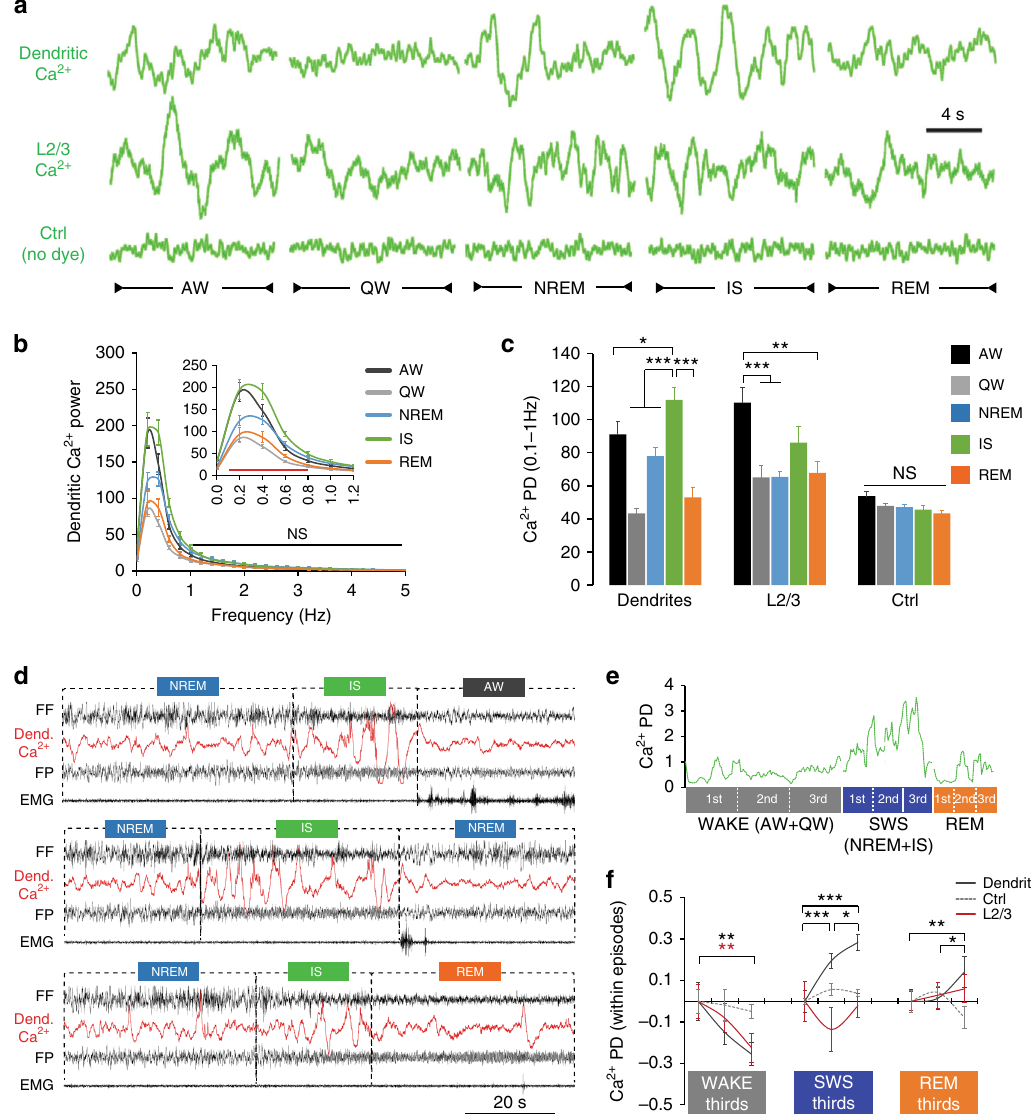
Fig. 2 Ca 2+ activity in populations of dendrites is largest at NREM transitions (IS). a Representative examples of fi bre-optic signals recorded in the three groups for each behavioural state. b Mean ( ± s.e.m.) power spectra of the dendritic Ca 2+ signal in each state (normalised to the mean across behavioural states). Signi fi cant differences between states were only found for frequencies < 1 Hz (two-way ANOVA; factor “ state ” : F 4,1248 = 50.6, P < 0.001; red line ( inset graph ): P < 0.05, black line ( main graph ): P > 0.05, Holm – Sidak test). c Mean ( ± s.e.m.) power density (PD) in the 0.1 – 1 Hz frequency band of the fi bre-optic signal in the three groups across behavioural states (factor “ state ” : F = 26.1, P < 0.001 three-way ANOVA; F = 7.51, 4,44(dendrites) 4,44(L2/3) P < 0.001 two-way ANOVA; F 4,20(Ctrl) = 2.67, P = 0.062 two-way ANOVA; * P < 0.05, ** P < 0.01 and *** P < 0.001, Holm – Sidak test). The effects of the “ dye ” and “ illumination ” factors for dendritic and L2/3 Ca 2+ activity are reported in Supplementary Fig. 3. d Examples of combined EEG/dendritic Ca 2+ recordings at the IS transitions to AW, NREM and REM sleep. e Behavioural episodes analysis method (see Methods). An average PD is calculated for each third across individual episodes of WAKE (AW+QW), SWS (NREM+IS) and REM sleep. The green line represents fl uctuations of dendritic Ca 2+ PD. f Mean ( ± s.e.m.) optical signal PD changes within episode thirds. Statistical signi fi cance was tested using one-way RM ANOVA. WAKE: F 2,20(dendrites) = 6.57, F 2,20(L2/3) = 6.8, P = 0.006 for both groups; SWS: F 2,20(dendrites) = 23.76, P < 0.001; REM: F 2,16(dendrites) = 7.3, P = 0.006. * P < 0.05, ** P < 0.01 and *** P < 0.001, Holm – Sidak test. N = 11 for dendrites and L2/3 groups and n = 6 for the Ctrl